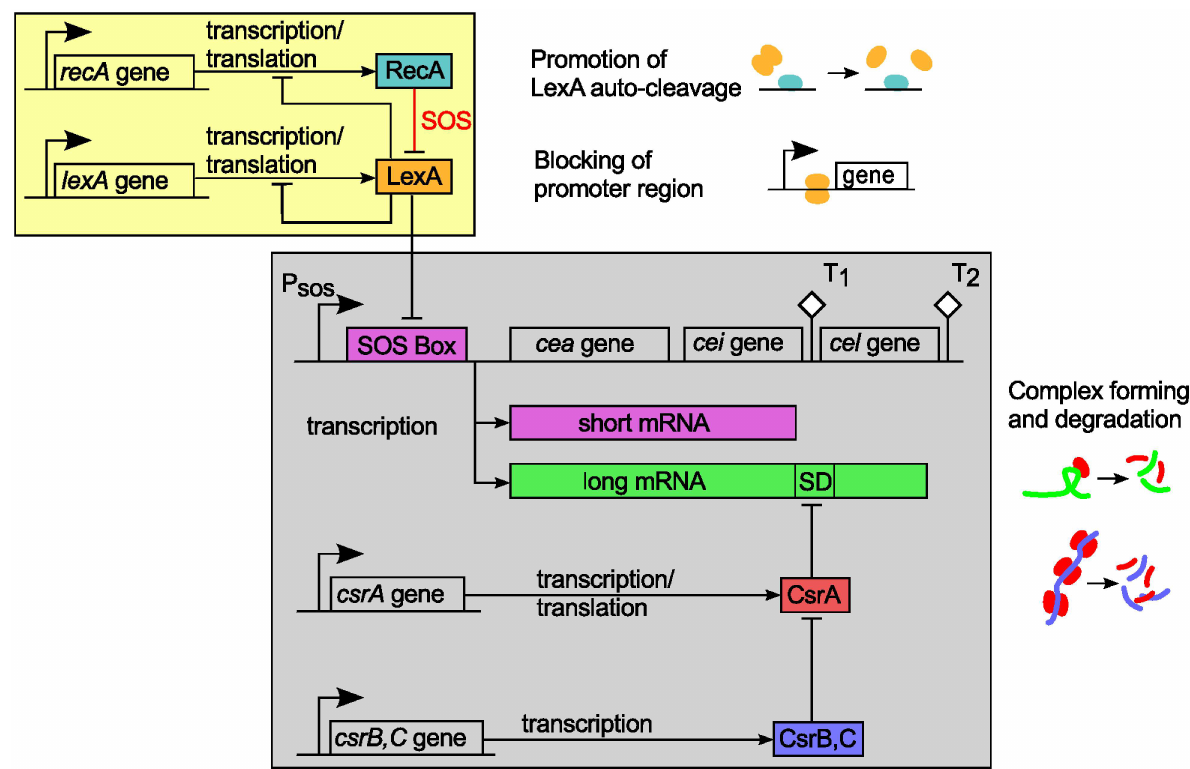
Fig 1. Regulation of colicin E2 expression and release. The interaction scheme is a generalized adaptionof that presented by Yang [28]. Under normalconditions, the SOS responsesystem (yellowbox) maintainsa constant level of LexA dimers, which repress the SOS promoterof the colicinE2 system (gray box). In the event of DNA damage,RecA is activated and promotes auto-cleavage of LexA. This permits the transcription of two different mRNAs: Short mRNA codes for componentsof colicinimmunity complexes (colicin gene cea , immunity gene cei ), whereaslong mRNA additionallyencodesthe protein that triggers cell lysis. Translation of long mRNA is regulatedby bindingof the protein CsrA to its Shine-Dalgarno sequence(SD). CsrA itself is regulatedby the two sRNAs CsrB and CsrC. Other elements: P sos : SOS promoter; T 1 and T 2 : transcriptional